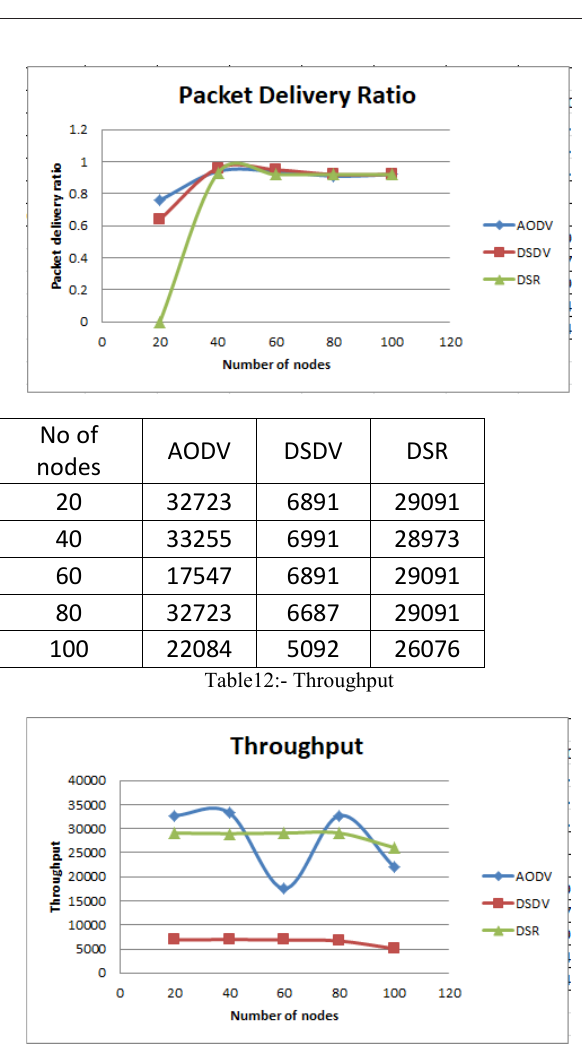
Table10:- Average end to end Delay